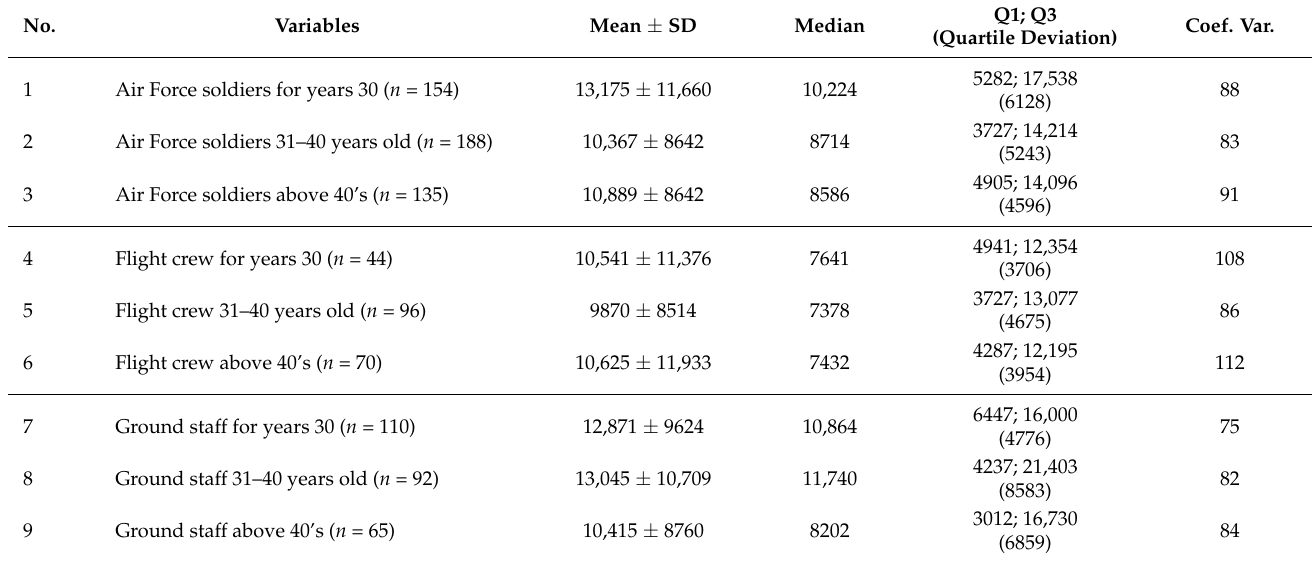
Table A1. Comparison of the total MET (professional work, transportation, housework, leisure time).